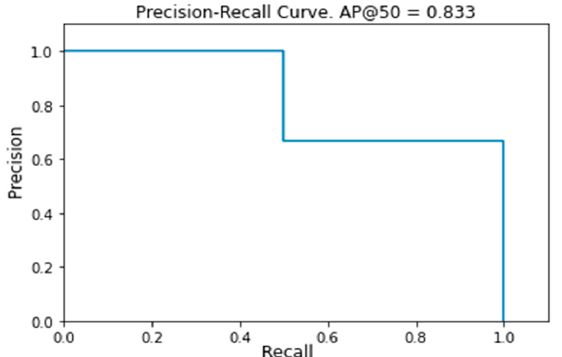
Figure 9. Example of Precision–Recall curve obtained during our experiments. The Average Preci- sion, that is the area below the curve, has a value of 0.833. In this example there are three Precision or Recall value changes, but that number of changes could be different for each